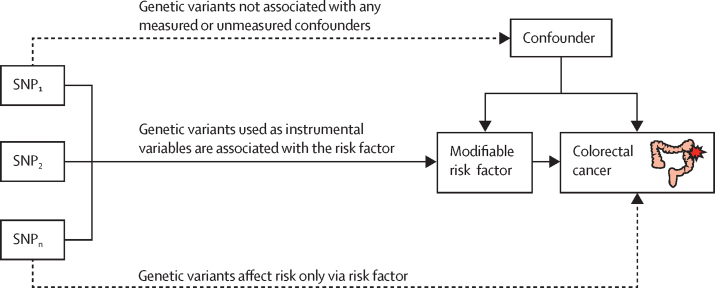
Principles of mendelian randomisation and assumptions that need to be satisfied to derive unbiased causal effect estimatesDashed lines represent direct causal and potential pleiotropic effects that could violate mendelian randomisation assumptions. SNP=single-nucleotide polymorphism.